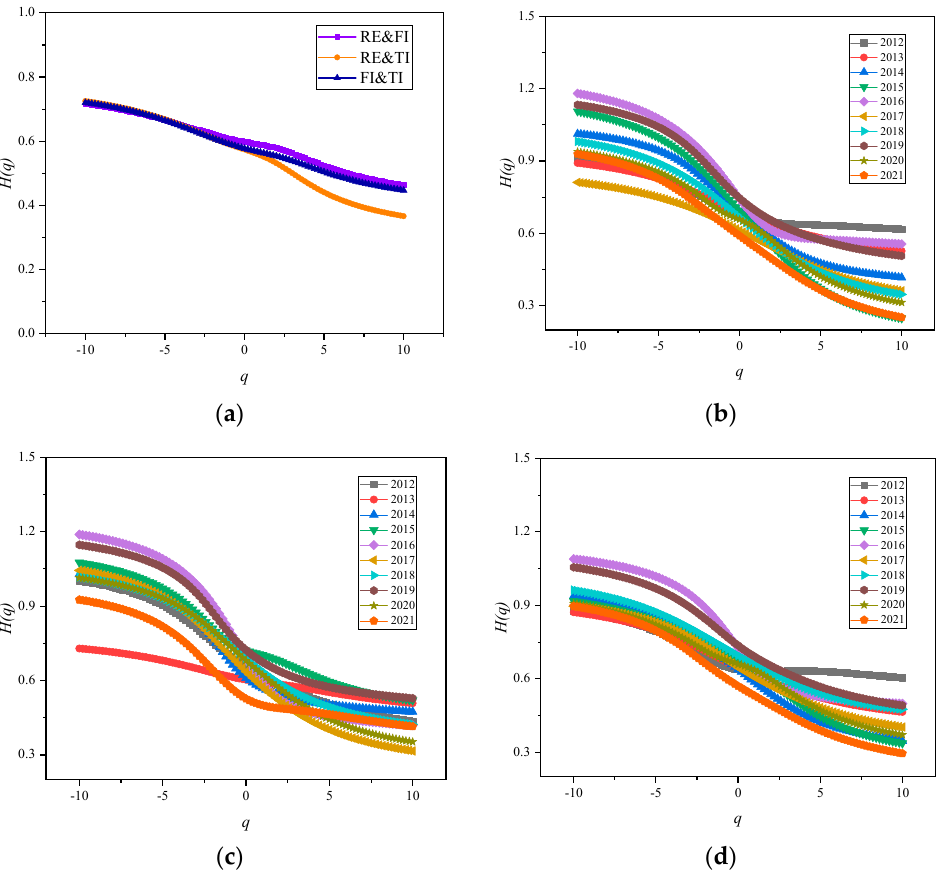
Figure 4. The 𝑞 - 𝐻(𝑞) results of the TI, FI, and RE. ( a ) Overall sample. ( b ) Subsample RE and FI. ( c ) Subsample RE and TI. ( d ) Subsample FI and TI.